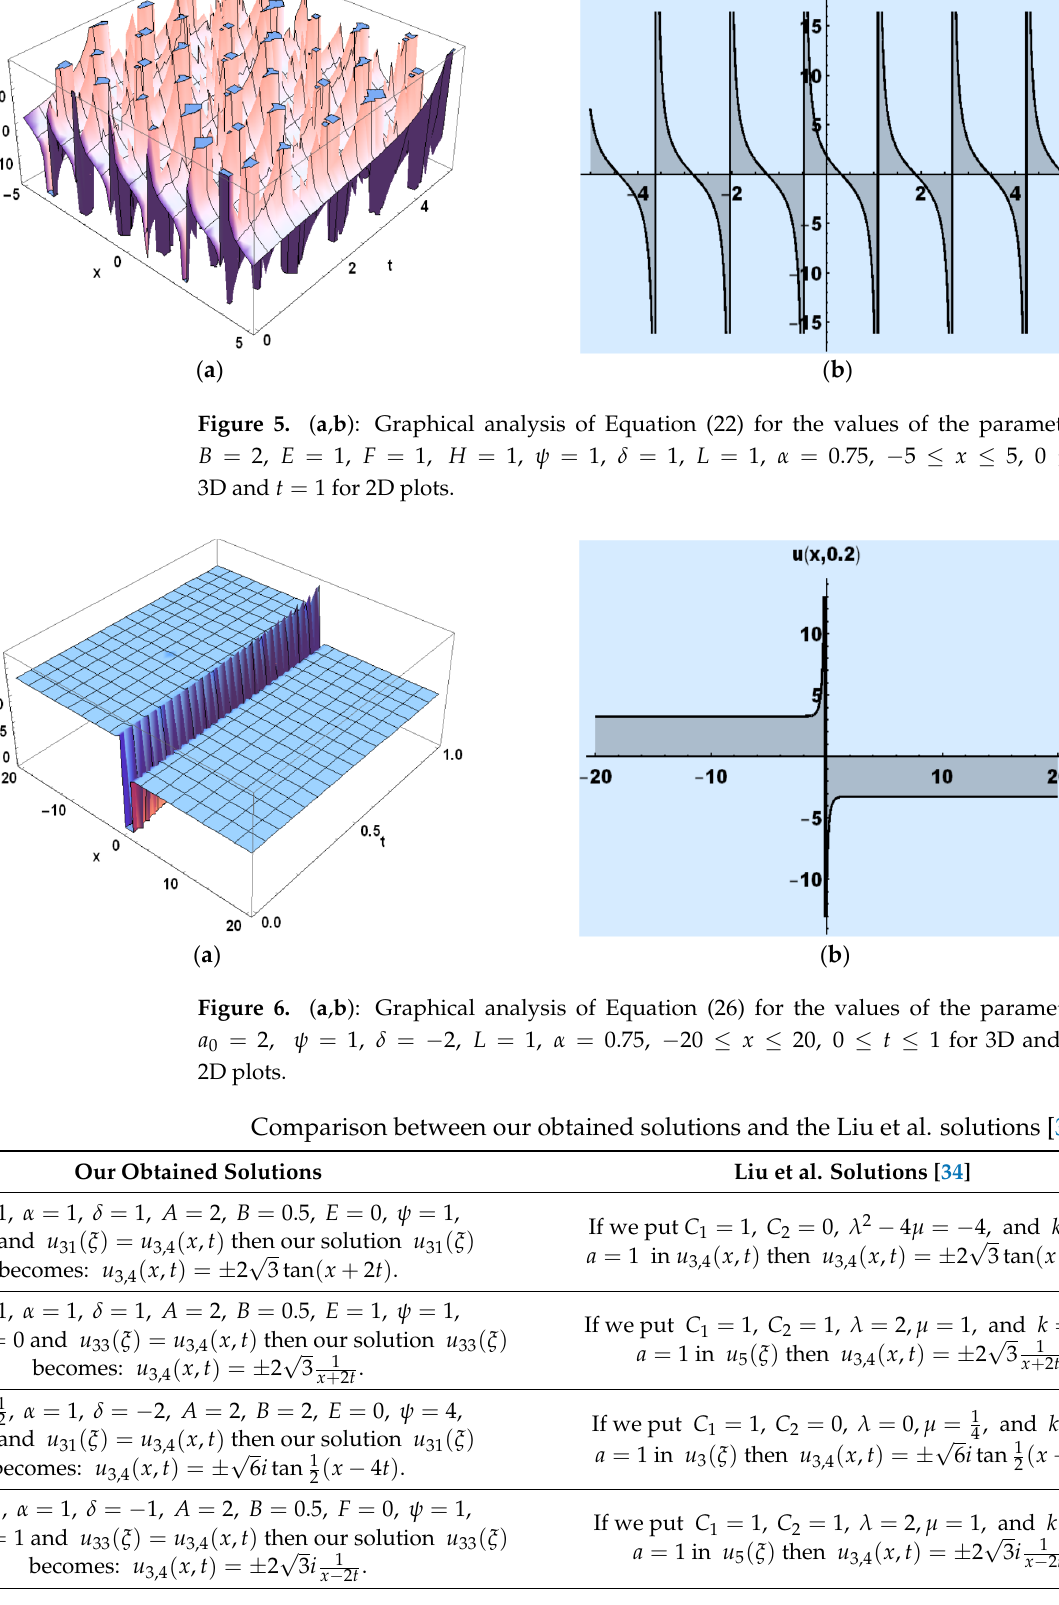
for 3D and 1.0  t for 2D plots.